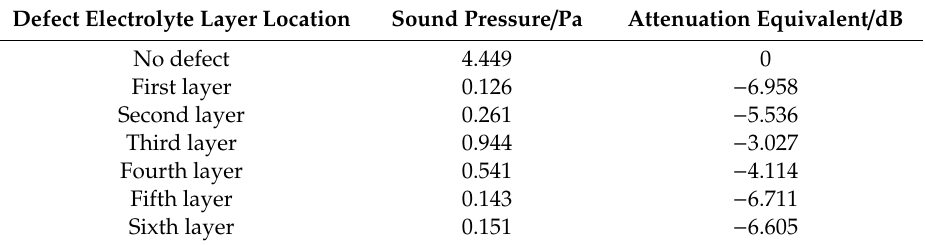
Table 4. The acoustic attenuation equivalent of the simulation ultrasonic transmission